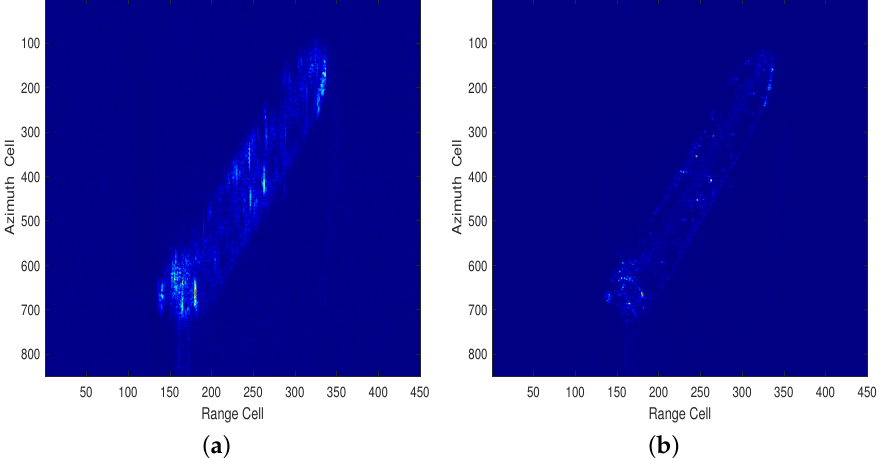
Figure 8. The performance of the motion compensation method on Gaofen-3 data. ( a ) SAR subimage. ( b ) RD imaging after motion